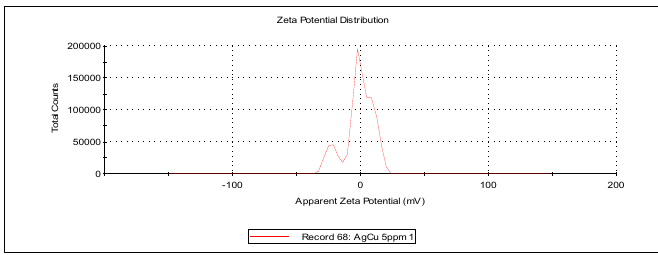
Figure 8. Representative distribution of zeta potential of AgCuNPs at a concentration of 2.5 + 2.5 mg/L, respectively.